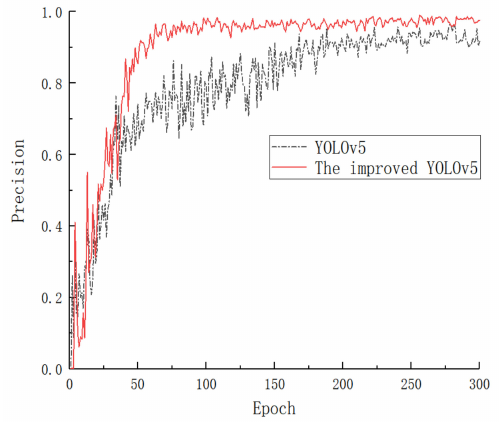
Figure 9. Change curve of recognition precision of YOLOv5 before and after improvement.